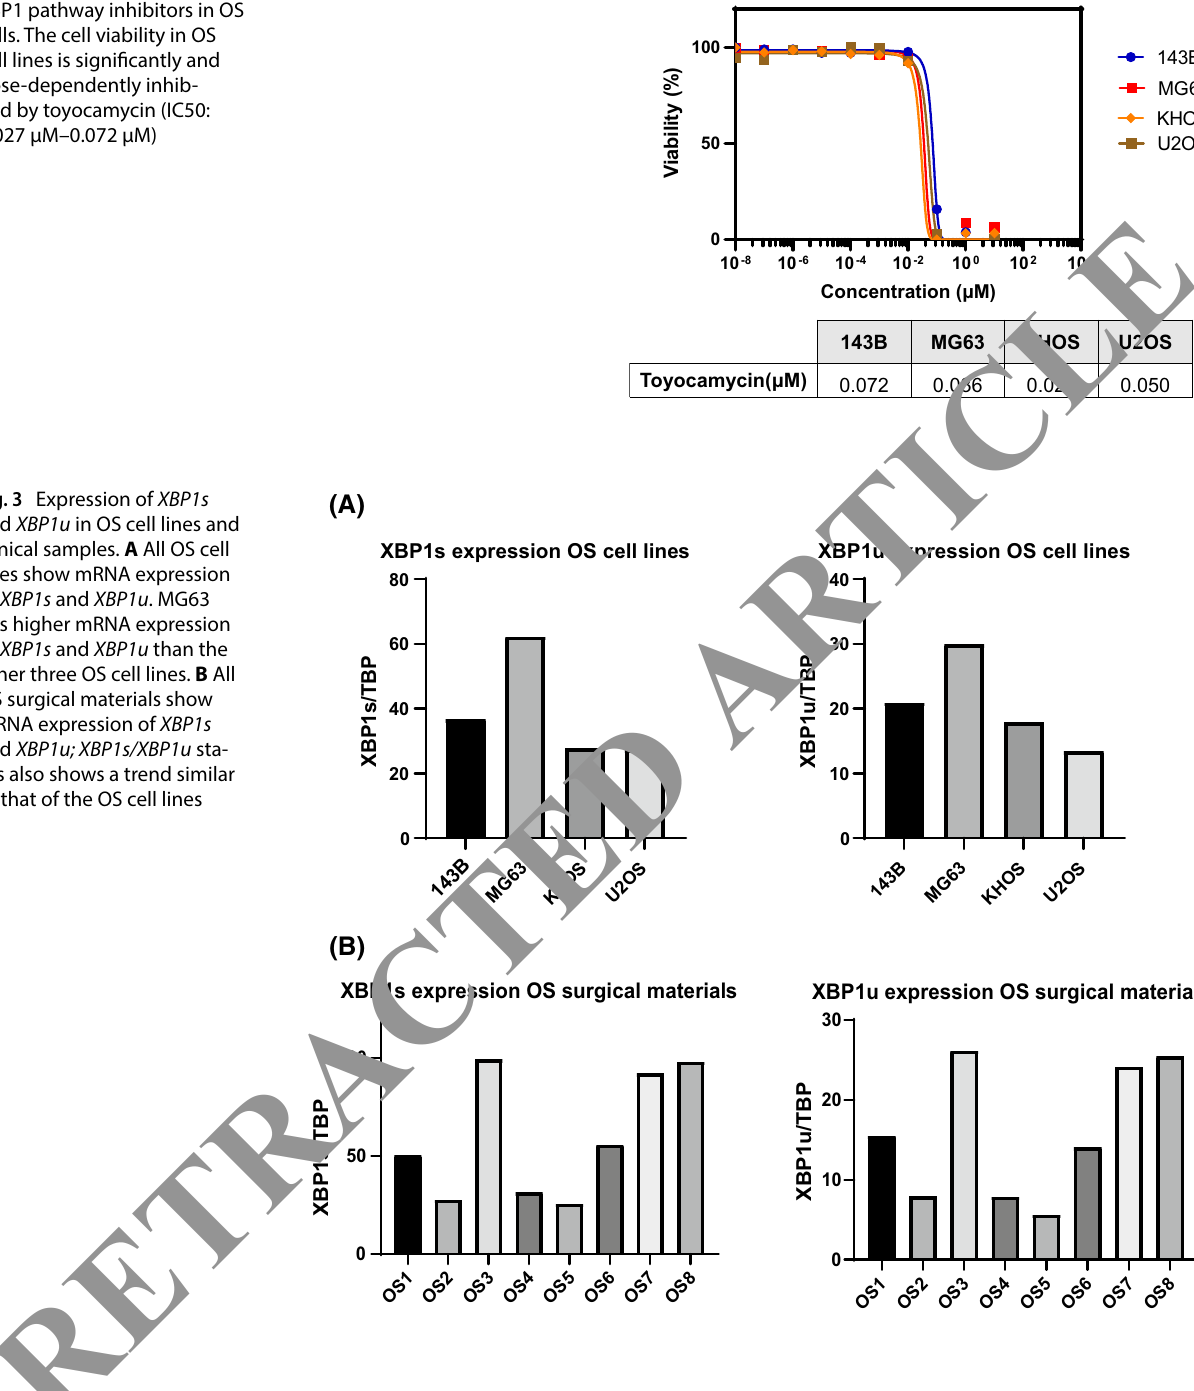
Fig. 2 The activity of IRE1α- XBP1 pathway inhibitors in OS cells. The cell viability in OS cell lines is significantly and dose-dependently inhib- ited by toyocamycin (IC50: 0.027 μM–0.072 μM)